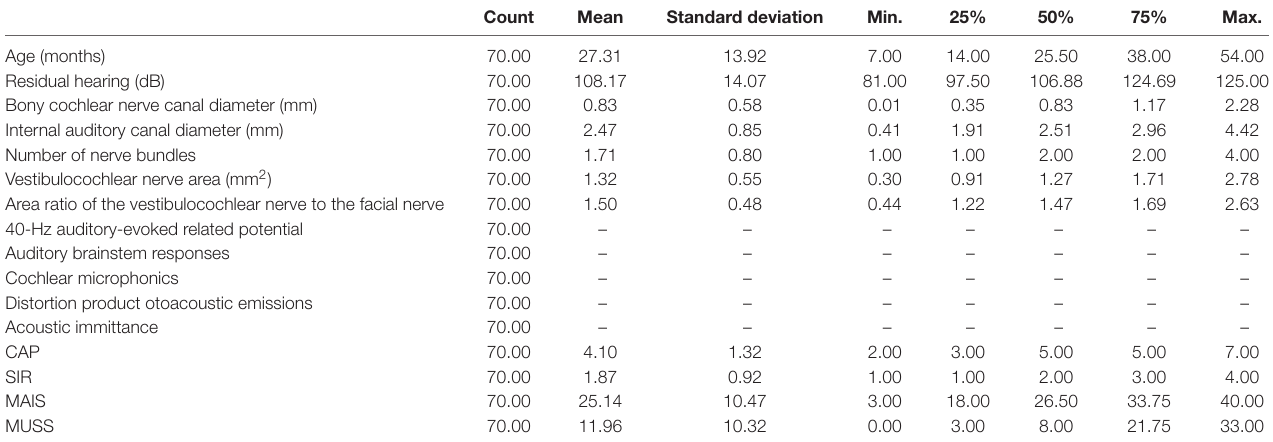
TABLE 1 | Descriptive statistics of patients.